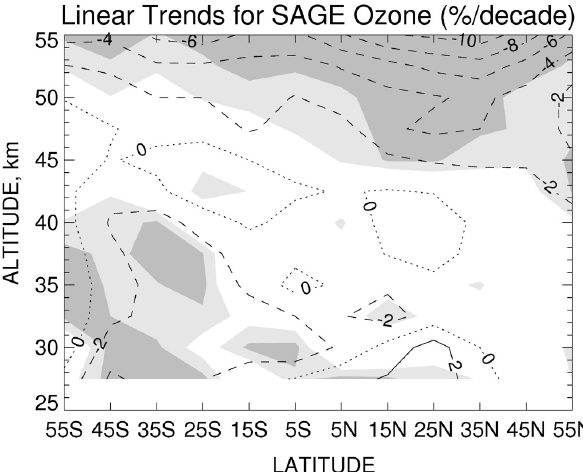
Fig. 11. As in Fig. 8, but the trends are from the SAGE II data from September 1992 through August 2005. The solid contour denotes a positive